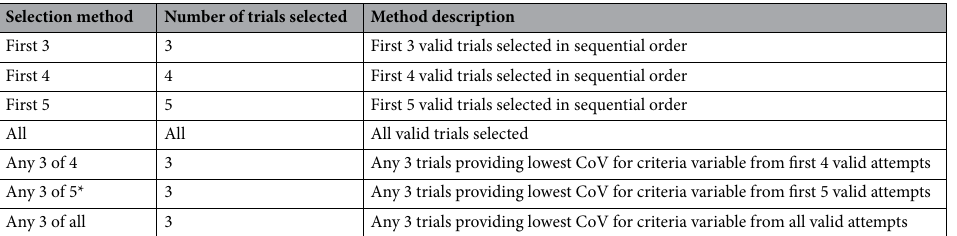
Table 3. Methods investigated for within session trial selection. CoV Coefficient of variation (%). *Current ERS standard (status